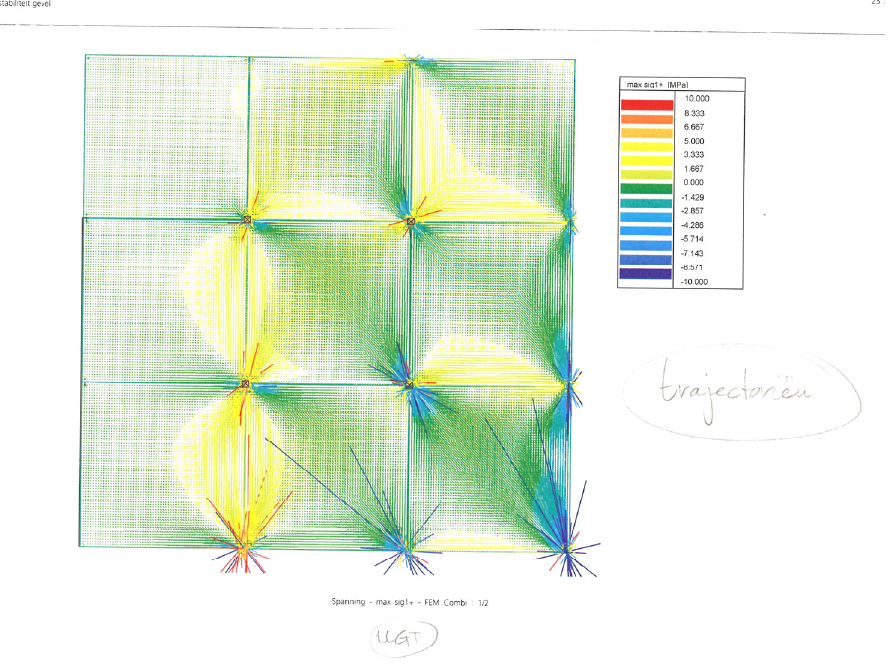
Figure 6: The flow of stability stresses through an all glass façade (with steel crosses in the joint where four glass panels